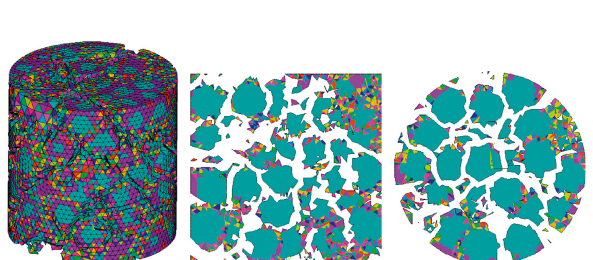
Figure 1: The damaged specimen and damaged cross section of Pre-1.